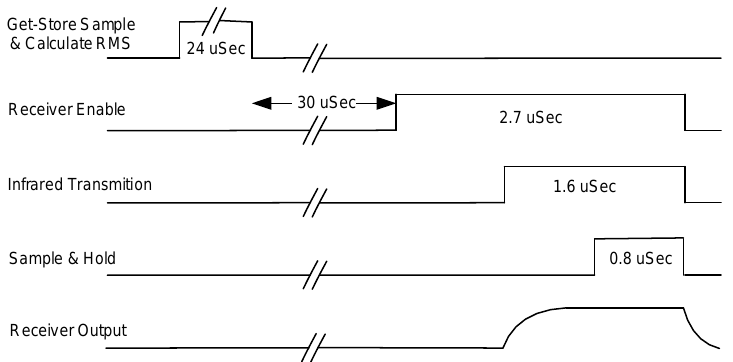
Figure 3. Synchronization diagram between emitter and receiver. The process is repeated every 250 µ s. The MCU is only active during the Store Sample & Calculate root-mean squared (RMS) step.